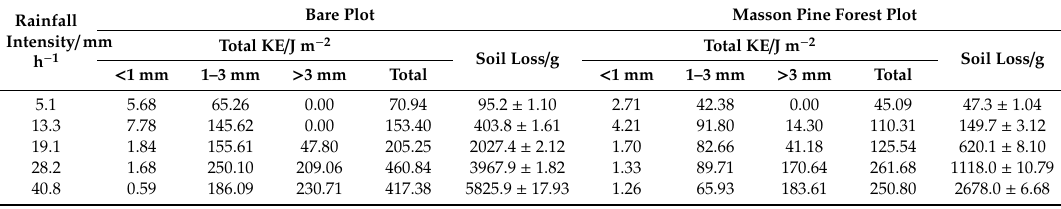
Table 4. Soil loss of two different types of plots under different rainfall events.